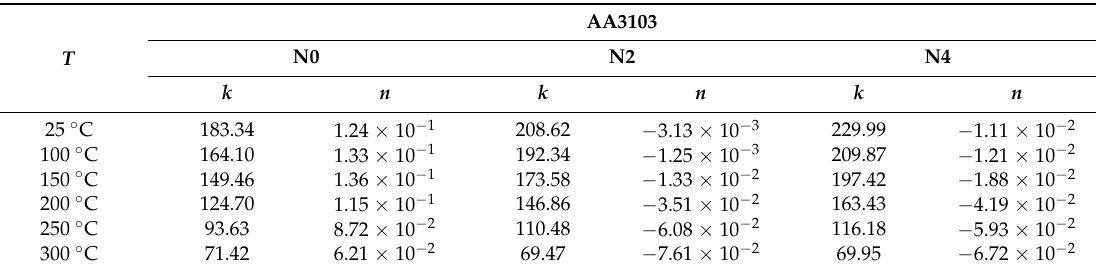
Table 5. Values for Hollomon’s parameters in the case of AA3103.